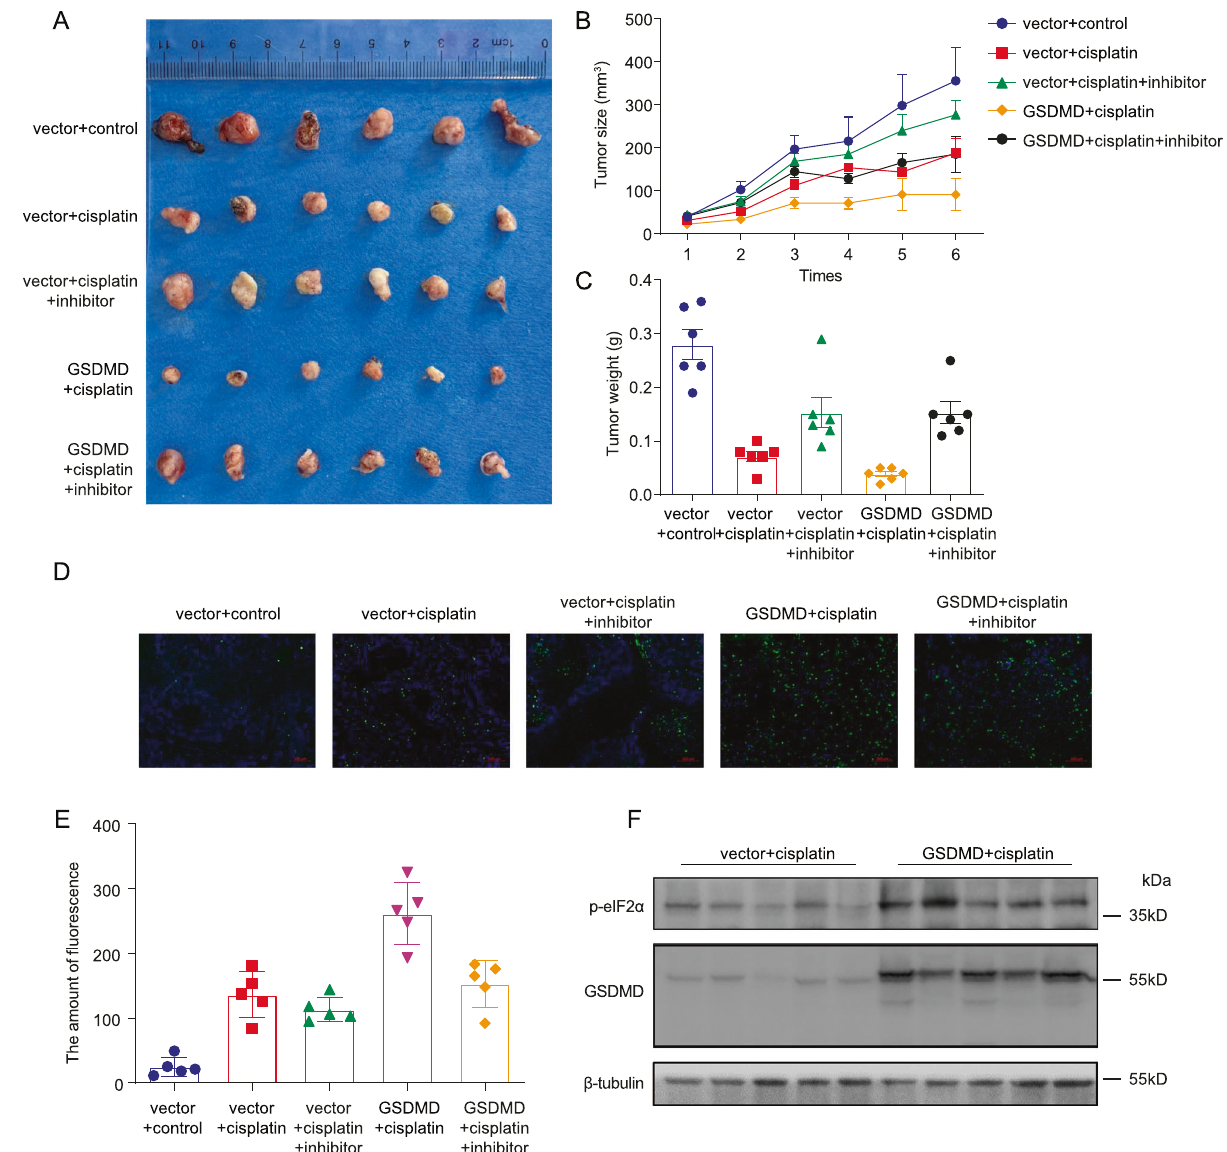
Fig. 6 The chemotherapy model of transplanted tumours in nude mice veri fi ed the promoting effect of GSDMD on cisplatin sensitivity. A Xenograft tumour of empty vector or GSDMD-overexpression Cal-27 cells with different treatment, the representative image of tumours at the endpoint. B Growth curve of nude mice from the time of tumour formation to the end of cisplatin chemotherapy. C The weight statistics for the tumours with different treatment. D TUNEL staining (green fl uorescence) was applied to detect cell apoptosis in transplanted tumours. DAPI staining was used to indicate the cell nucleus. E Statistical analysis of tunel staining. F The tumours were homogenised and the protein of GSDMD and phosphorylated eIF2 α was detected by western